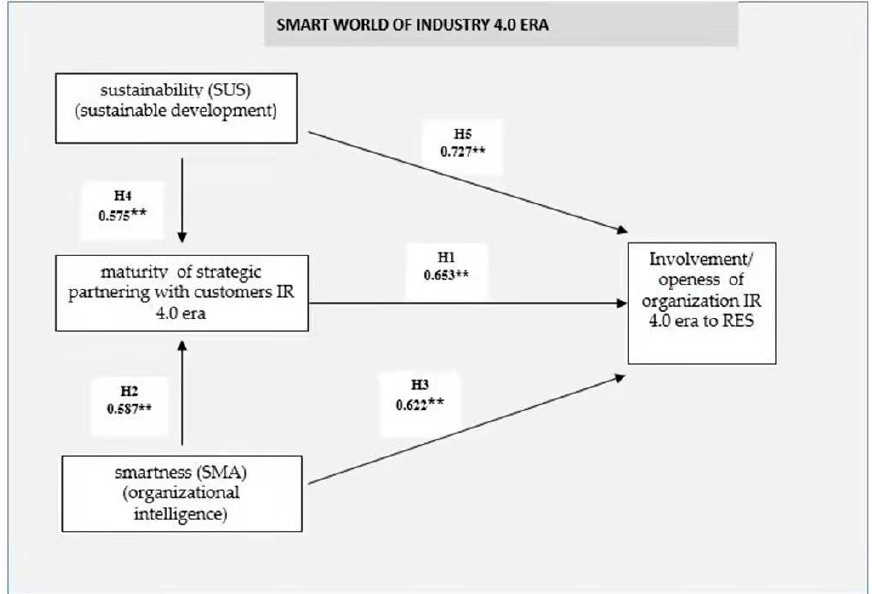
Figure 1. Research model and its verification. (** Correlation significant at 0.01 (two-sided). Source: Own study).